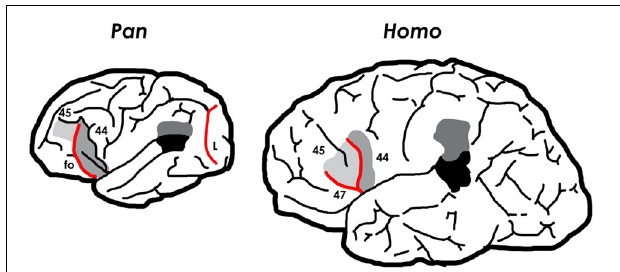
FIGURE 3 | Left hemispheres of a chimpanzee and human brain illustrating different sulcal patterns. The chimpanzee has a lunate sulcus ( L ) at the rostral border of the primary visual cortex, which was lost during human evolution. The chimpanzee also has a fronto-orbital sulcus ( fo ) that delimits so-called “Broca’s cap” (BA 44 and sometimes part of BA 45). Most of fo became buried deep within the brain as hominin brains enlarged. Consequently, the bulge on human brains that appears to occupy the same location as the orbitolateral swelling in chimpanzee frontal lobes, contains BA 47 and BA 45, in addition to two new sulci (the horizontal and ascending limbs of the anterior Sylvian fissure) that form two sides of the pars triangularis (BA 45). The fo , L , and sulci bordering BA 45 are exaggerated and reddened